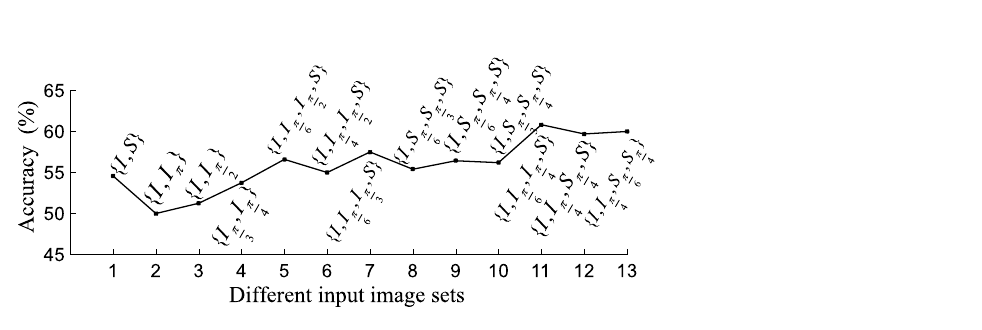
Figure 5. The impact of different input image sets on FGVC